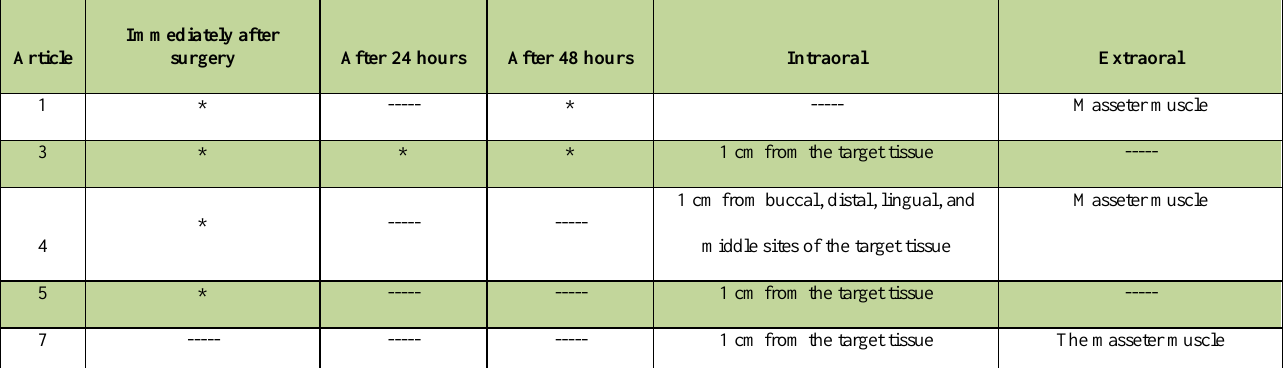
Table 3: Location And Time Of Laser